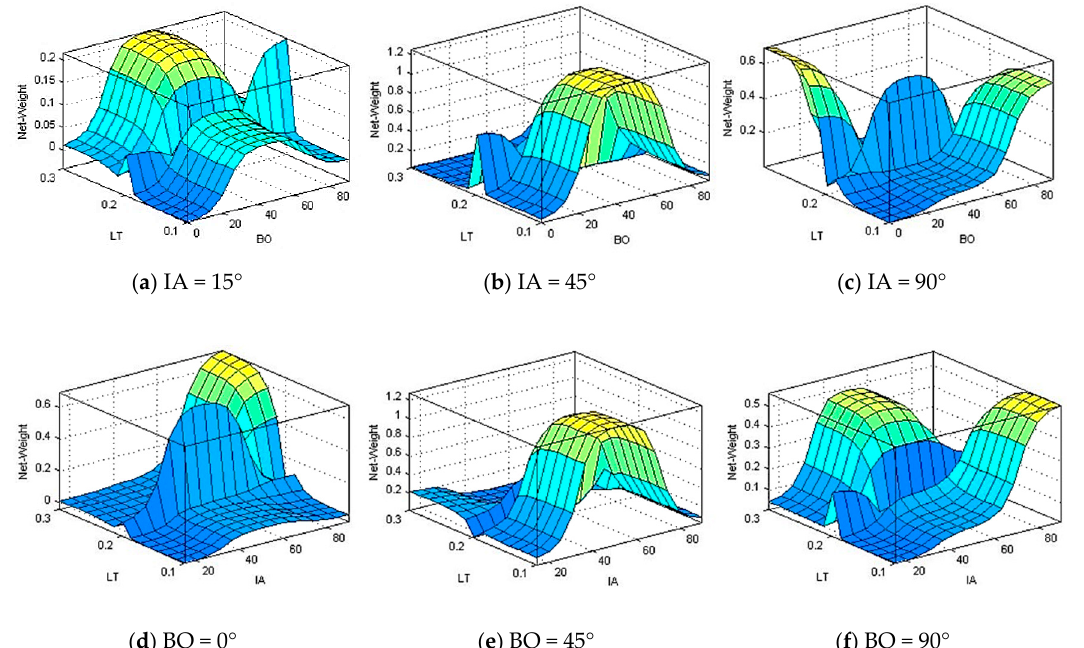
Figure 15. Net weight gain in relation to change of building orientation (BO), layer thickness (LT), and impact angle (IA) at ( a ) IA = 15°, ( b ) IA = 45°, ( c ) IA = 90°, ( d ) BO = 0°, ( e ) BO = 45°, and ( f ) BO = 90°.